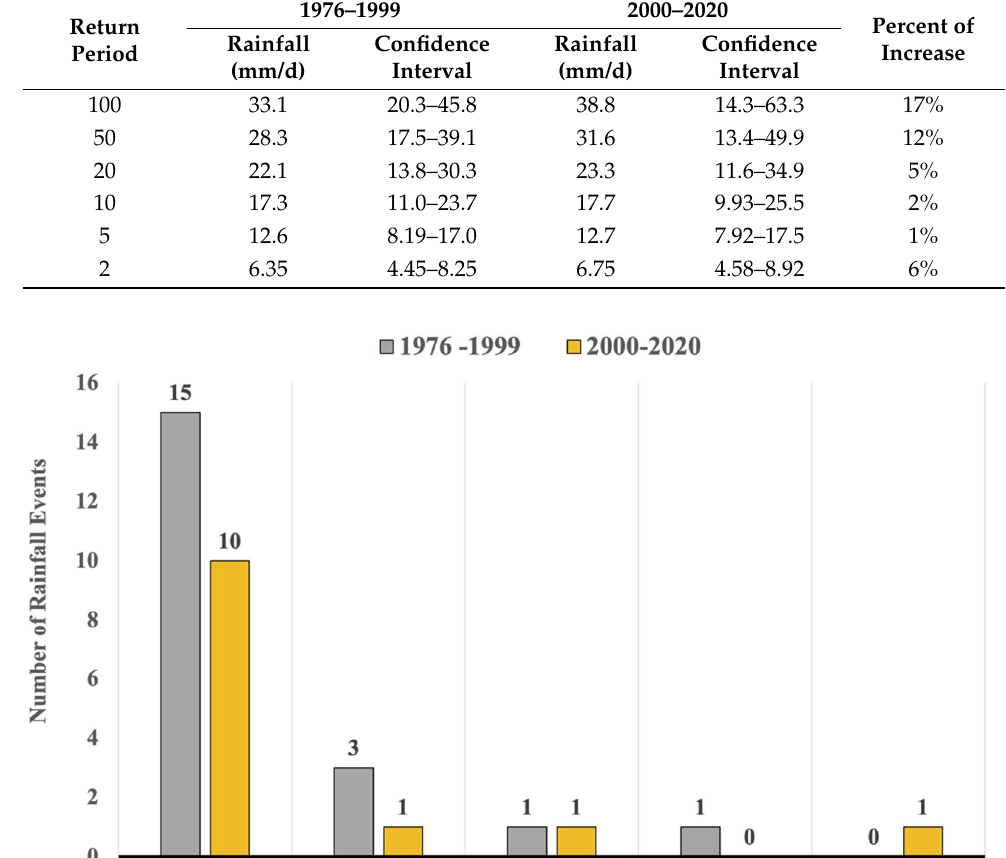
Table 7. Comparison of return period intensities between the periods of 1976 to 1999 and 2000 to 2020.